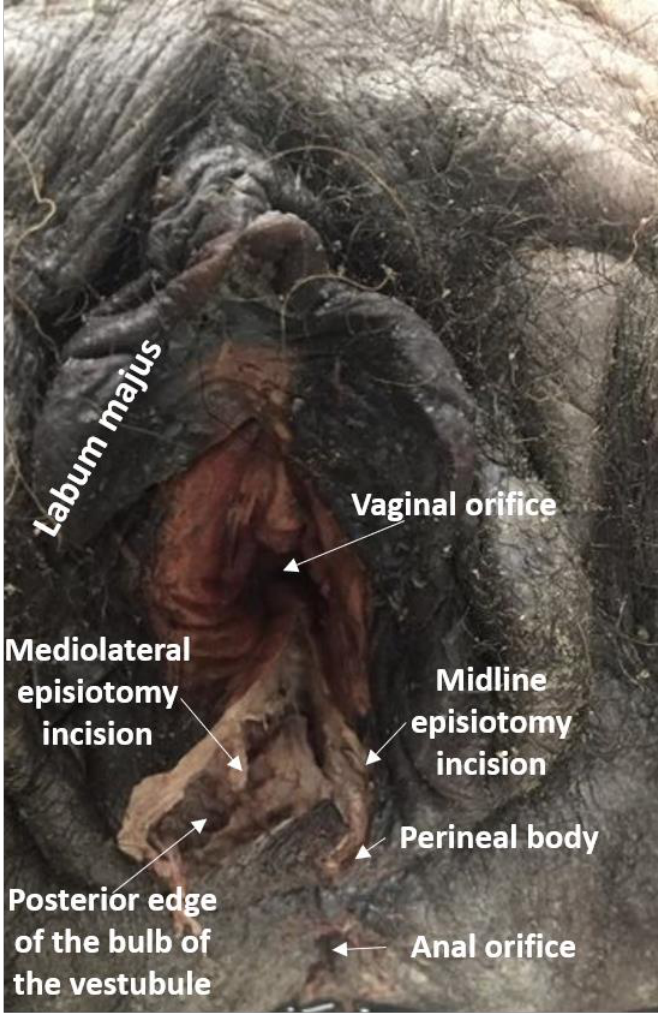
Figure 2. Female perineum with a midline episiotomy incision and a low-angle mediolateral incision. Midline episiotomies endanger the perineal body and many mediolateral incisions endanger the bulb of the vestibule and associated neurovasculature, as depicted here.